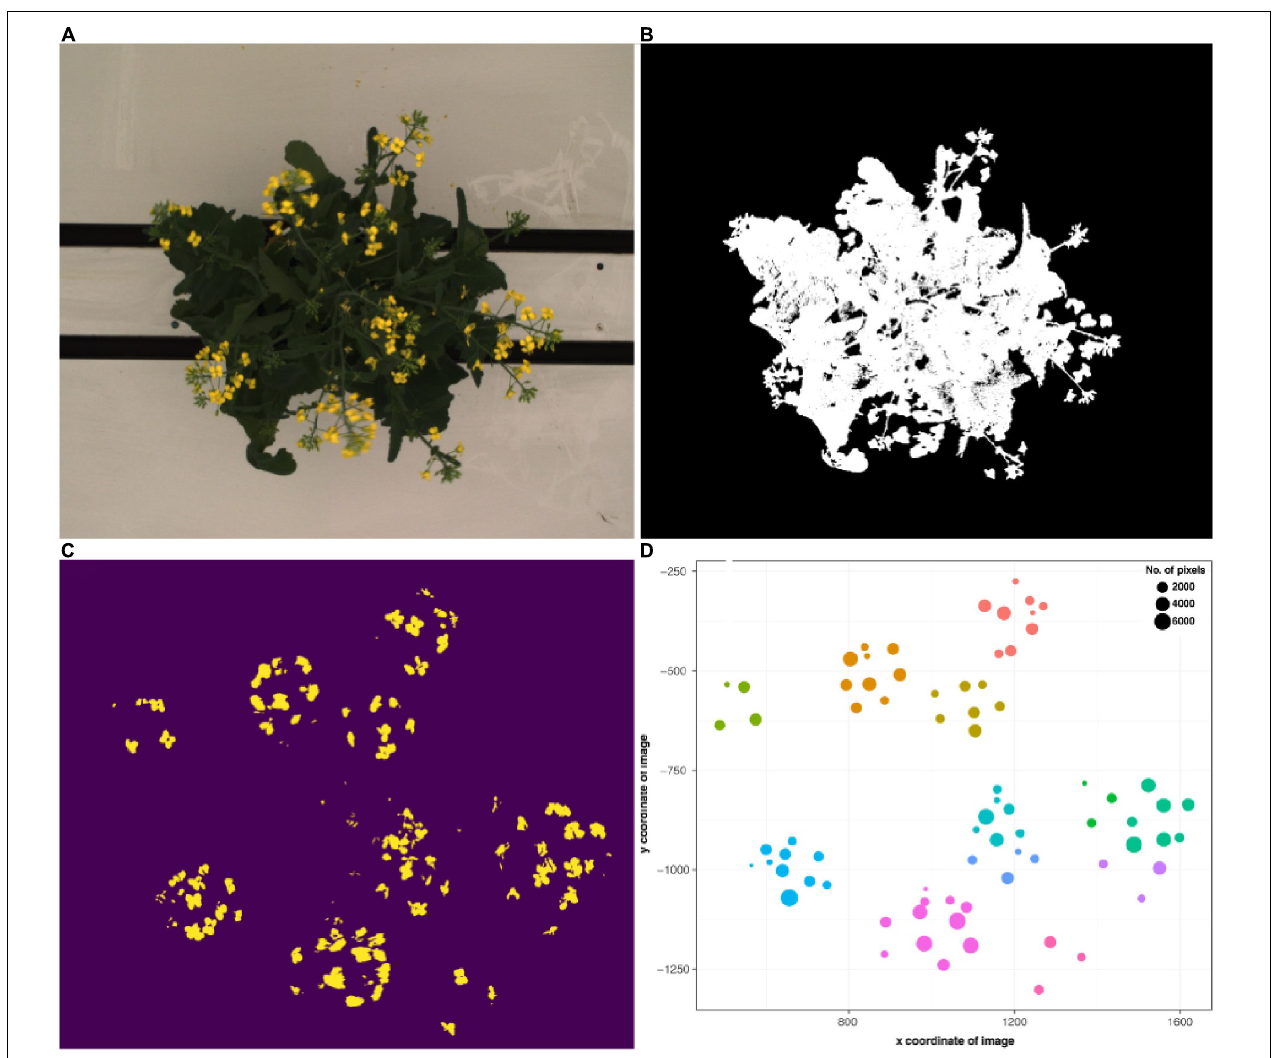
FIGURE 4 | Flower and raceme branch detection workflow. (A) Exemplary RGB top view image of a flowering B. napus individual. (B) Segmented image. (C) Image components in the blue yellow channel after pixel-based thresholding. (D) Binary image components mapped according to their x and y coordinates and number of pixels. Colors correspond to clusters assigned via hierarchical clustering and roughly correspond to raceme